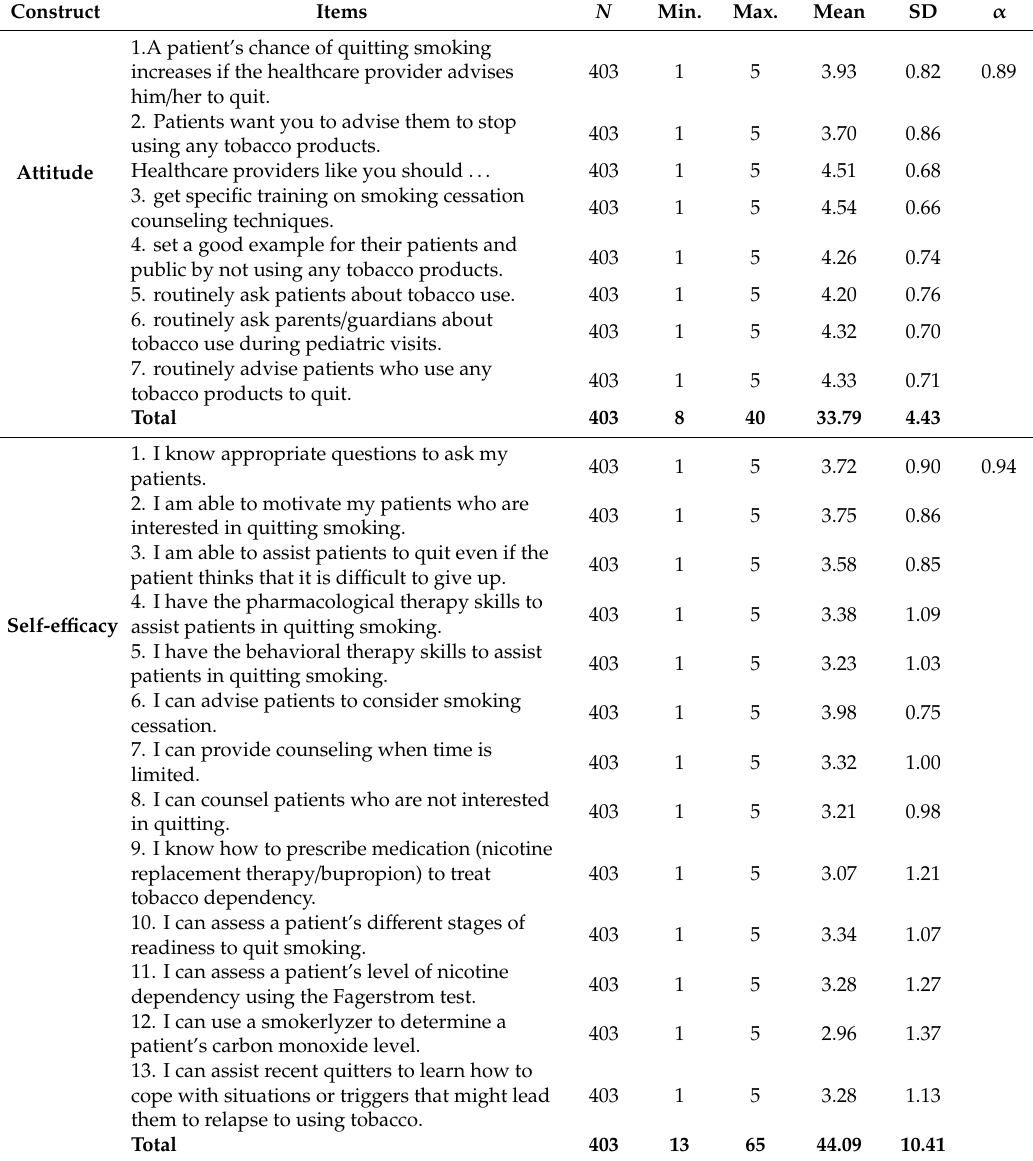
Table 6. Constructs and item